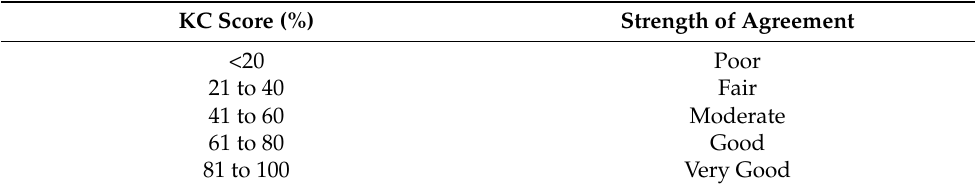
Table 1. Interpretation of kappa coefficient (KC) score.